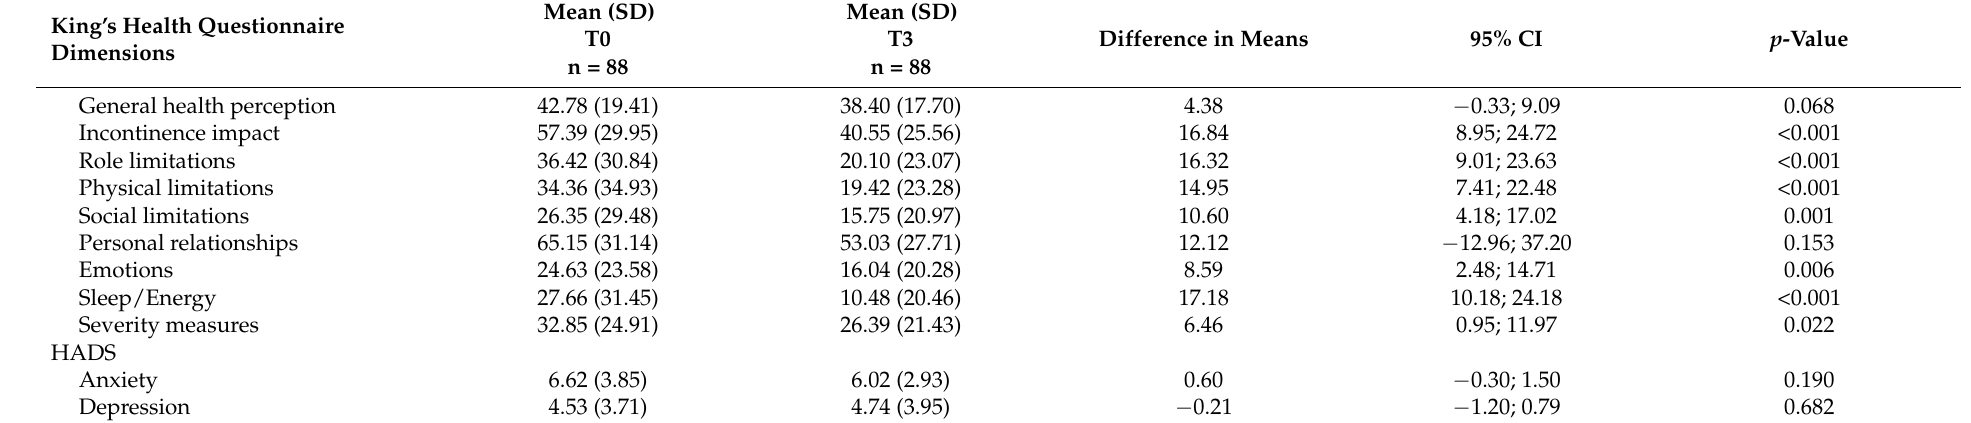
Table 9. Evolution of adherence, quality of life, and emotional state during follow-up between T1 and T6. King’s Health